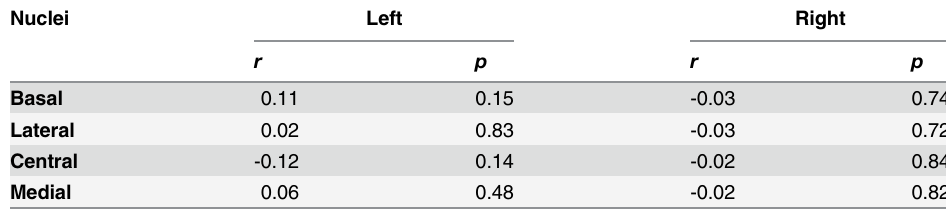
Table 2. Volumetric measurements in the probabilistic nuclei and correlations with age (controlling for gender and study group).